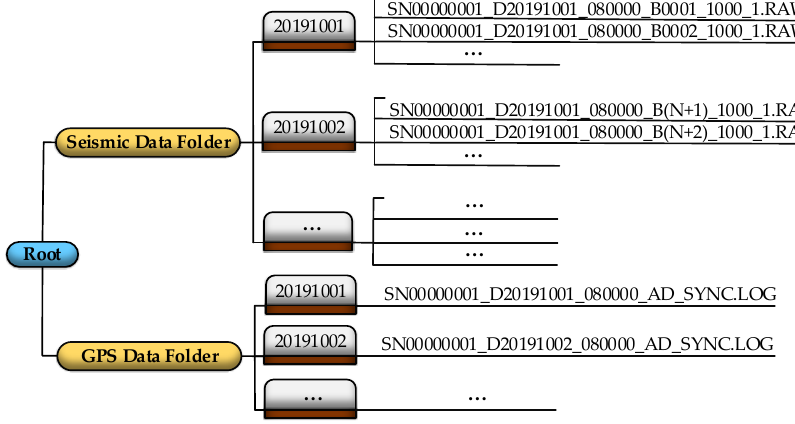
Figure 7. Directory structure of seismic data files in the SD card.